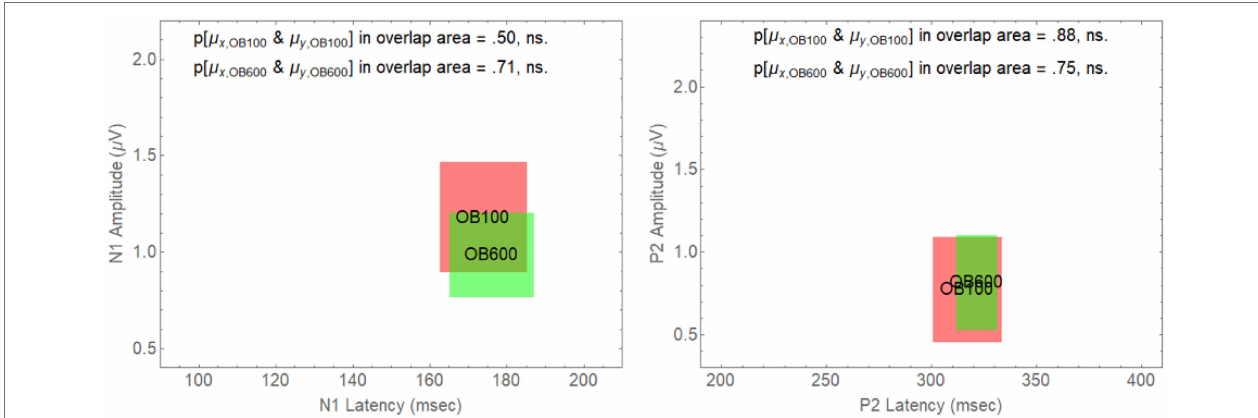
FIGURE 5 | Overlap between the CI rectangles for the 100 and 600 ms delay conditions for older adults in Babble. Left Panel : CI rectangles for older adults in the Babble condition for onset delays of 100 and 600 ms for the N1 wave. Right Panel : CI rectangles for older adults in the Babble condition for onset delays of 100 and 600 ms for the P2